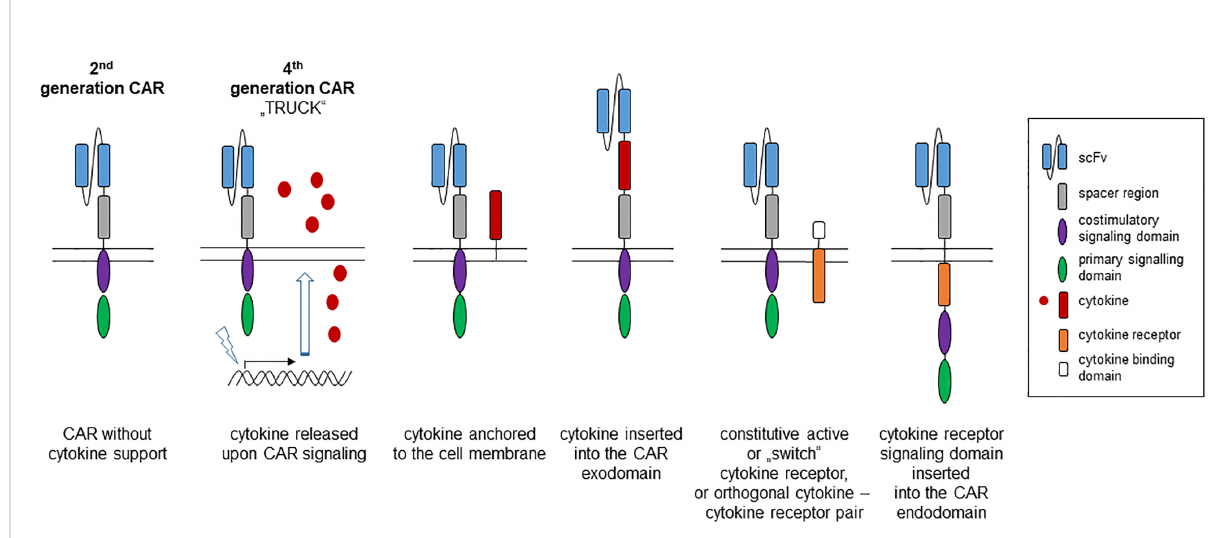
FIGURE 1 Strategies to provide cytokine help to a “ second generation ” CAR. The canonic 2 nd generation CAR is composed of an antibody derived binding domain, spacer, transmembrane and two linked intracellular signaling domains, one providing the primary activation ( “ signal-1 ” ) and the other the costimulatory signal ( “ signal-2 ” ). Support by a transgenic cytokine ( “ signal-3 ” ) can be made available by CAR triggered synthesis and release of the cytokine (4 th generation CAR, so-called TRUCK), by anchoring the cytokine to the cell membrane or by inserting into the CAR exodomain. A cytokine signal can also be delivered by co-expressing a constitutive active cytokine receptor or by inserting the cytokine receptor signaling domain into the intracellular CAR